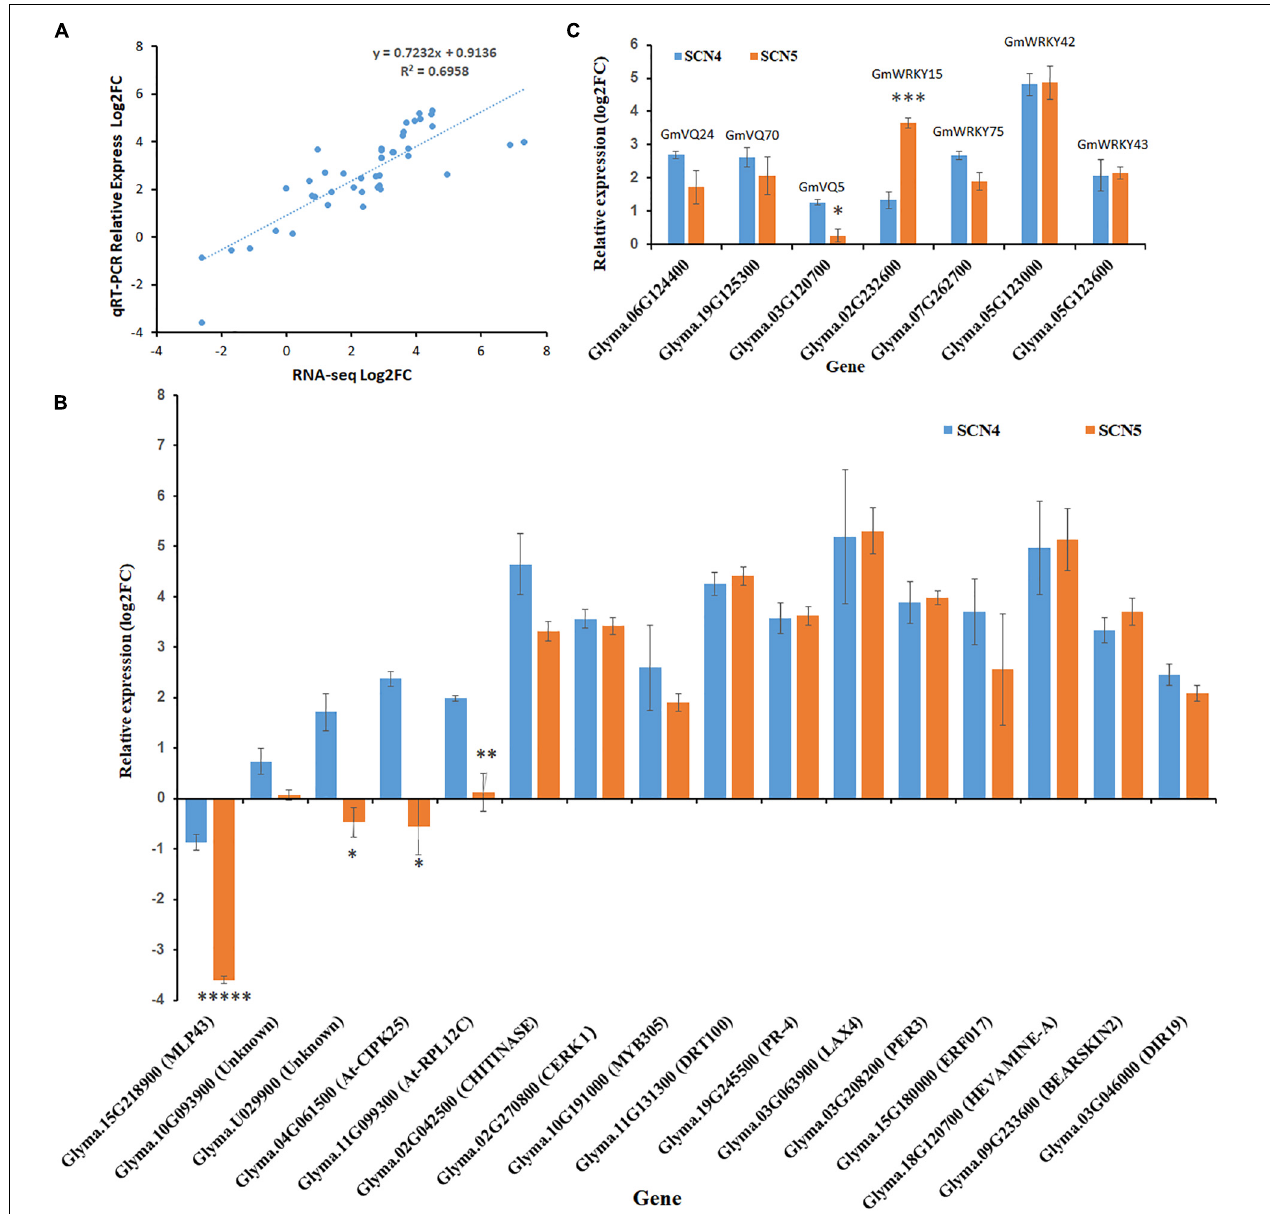
FIGURE 9 | Validation of differentially expressed genes (DEGs) by qRT-PCR. (A) Correlation of DEG expression levels between RNA-seq and qRT-PCR. (B) Relative expression of VQ and WRKY genes. (C) Relative expression of 16 other DEGs. For panels (B,C) , the x -axis displays different genes and gene annotation, and the y -axis is relative expression level (log 2 FC-fold change). Relative expression level was calculated with the – (cid:49)(cid:49) Ct method using the actin gene as an endogenous control. The error bar stands for the SE. The asterisks represent significant difference by t test ( ∗ p < 0.05; ∗∗ p < 0.01; ∗∗∗ p < 0.005; and ∗∗∗∗∗ p <